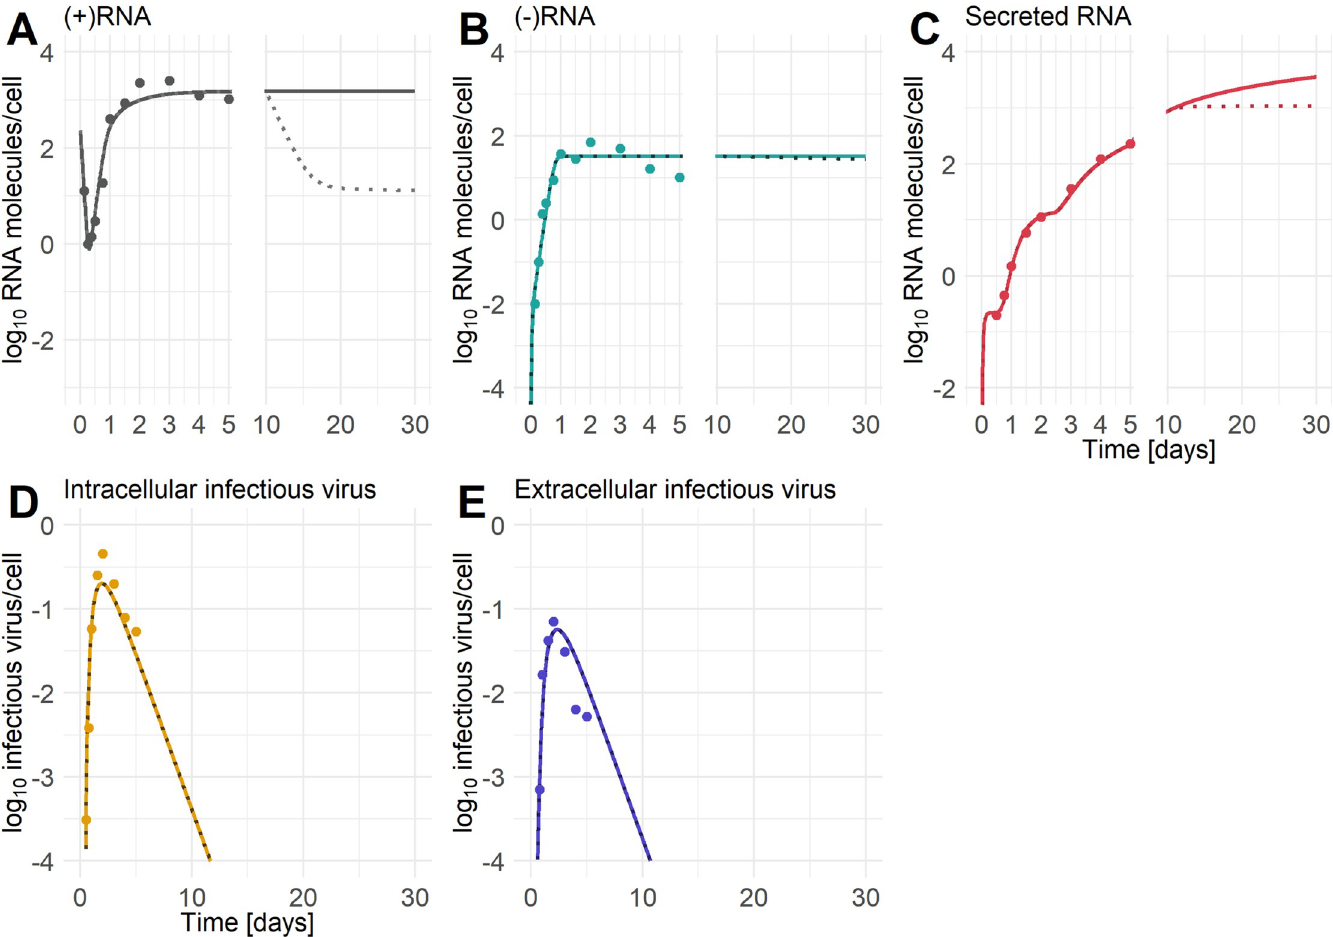
Fig 5. Effect of antiviral drug treatment given 10 dpi in the combined model (CM 4 ). Here we assume the drug is the NS5A inhibitor daclatasvir and that it acts by inhibiting HCV RNA synthesis with an effectiveness ε R = 0.99 and virus assembly with an effectiveness ε A = 0.998. The solid line denotes the model’s prediction with no drug present, whereas the dotted line shows the model’s prediction after drug treatment is started on day 10 pi (see S1 Data).